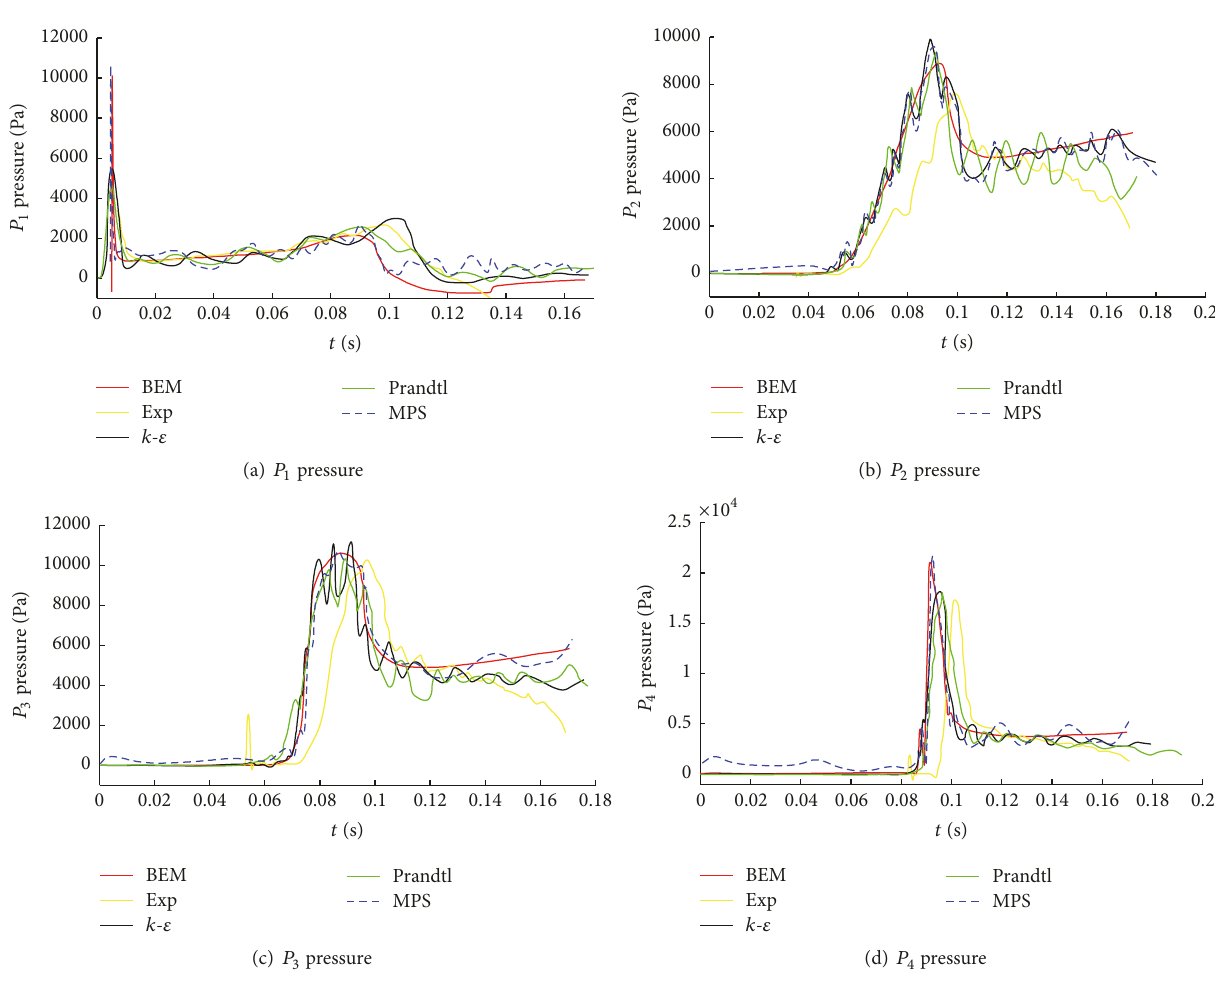
Figure 13: Pressures comparison of case